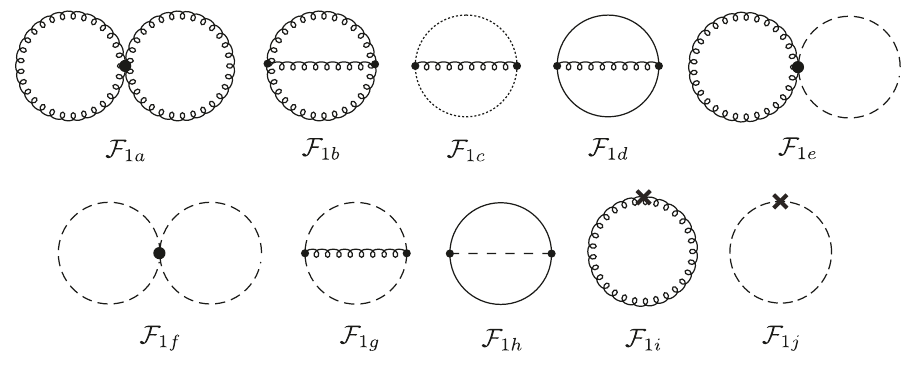
Figure 2 . Two-loop contributions to the SYM 4 , 4 free energy. The crosses are the thermal coun- terterms produced by the last two terms of